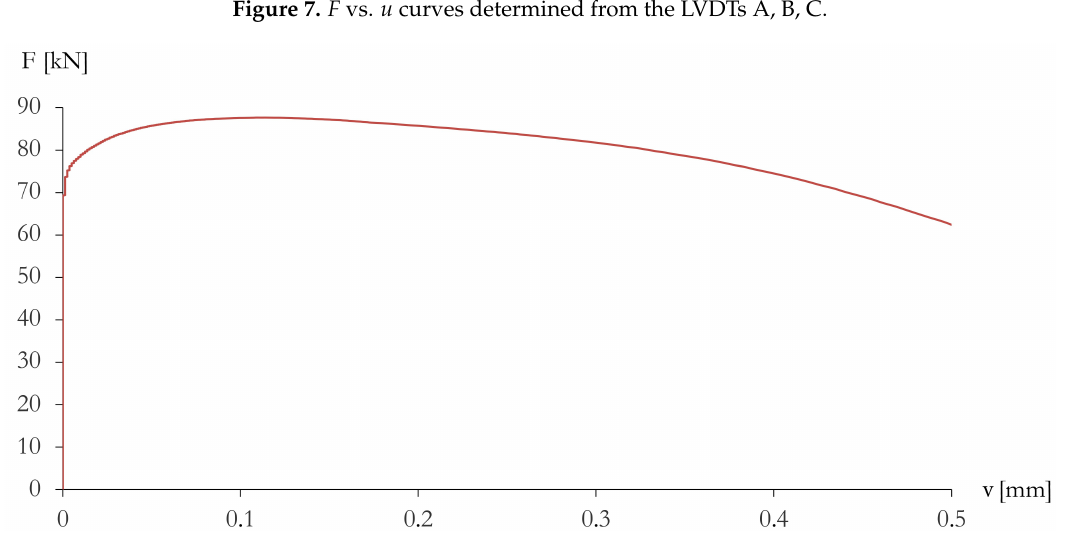
Figure 7. F vs. u curves determined from the LVDTs A, B, C.